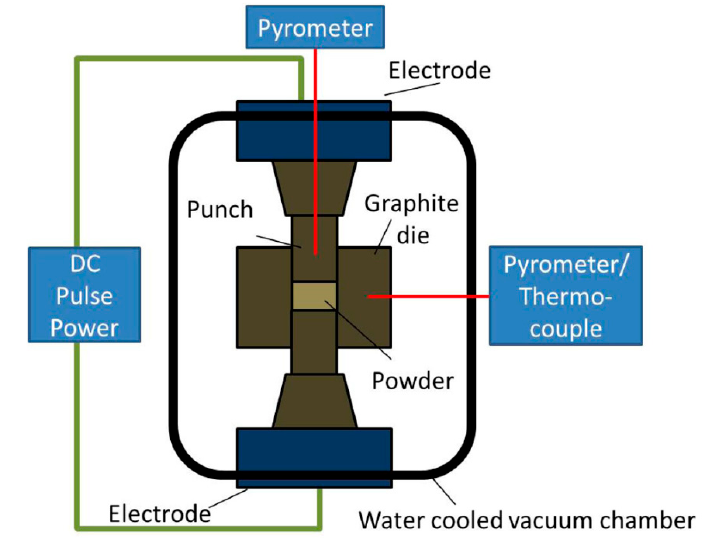
Figure 1. Principles and mechanisms of the spark plasma sintering (SPS) process [79]. Copyright Wiley and Sons, 2014.